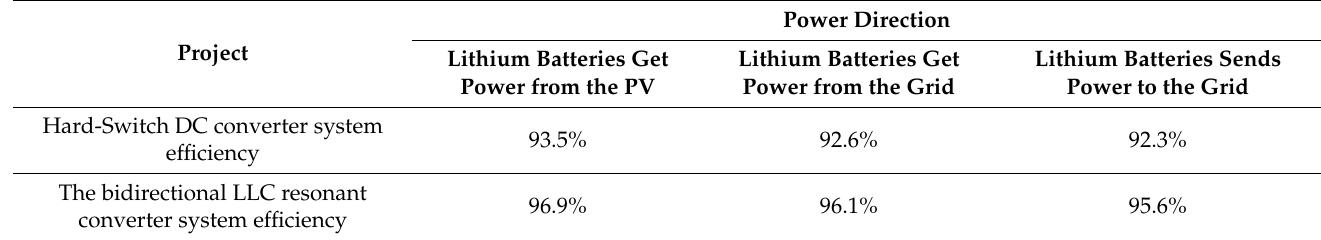
Table 2. Efficiency comparison under different operation